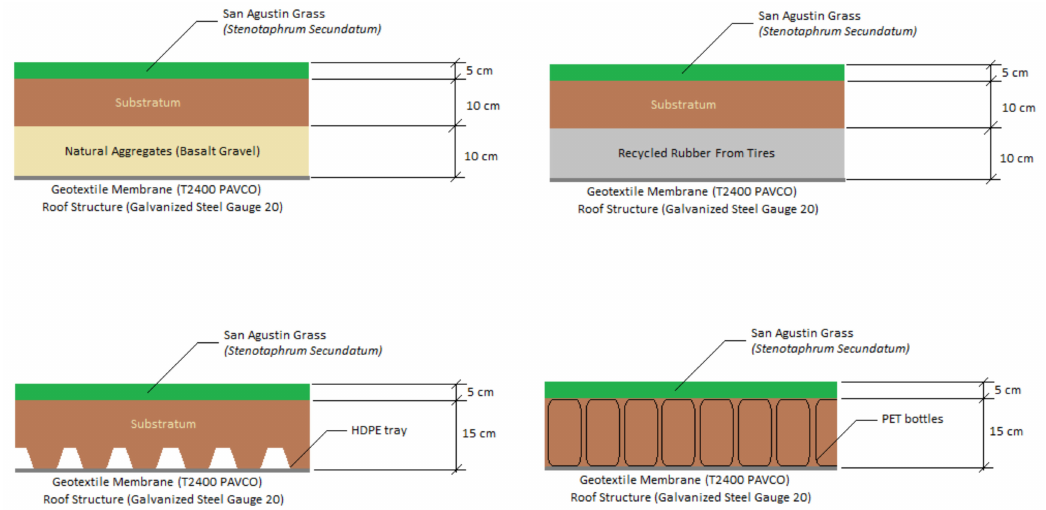
Figure 1. Cross sections of the green roof prototypes made out of recycled or reused